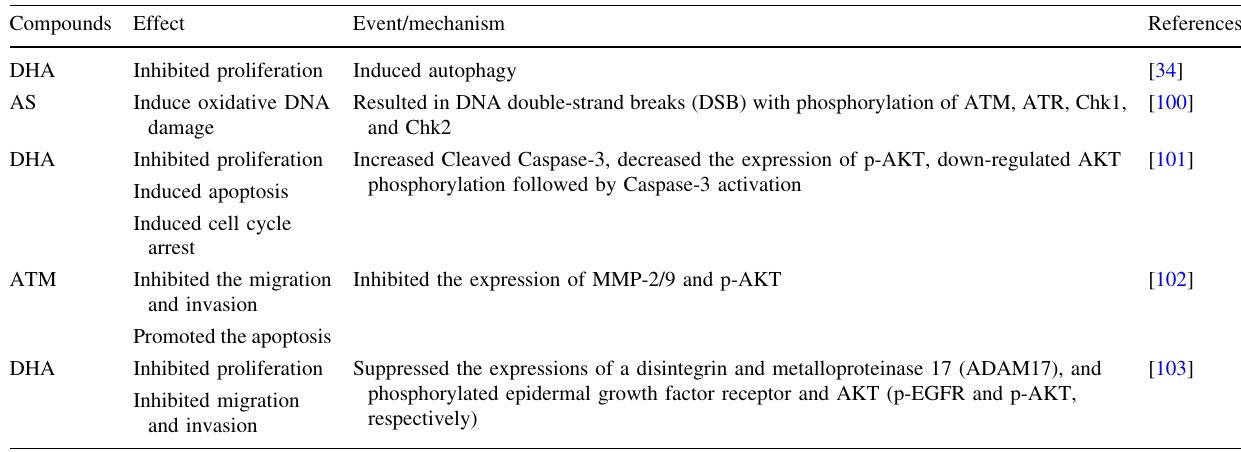
Table 5 Anti-brain glioma cells activities of artemisinins Compounds Effect